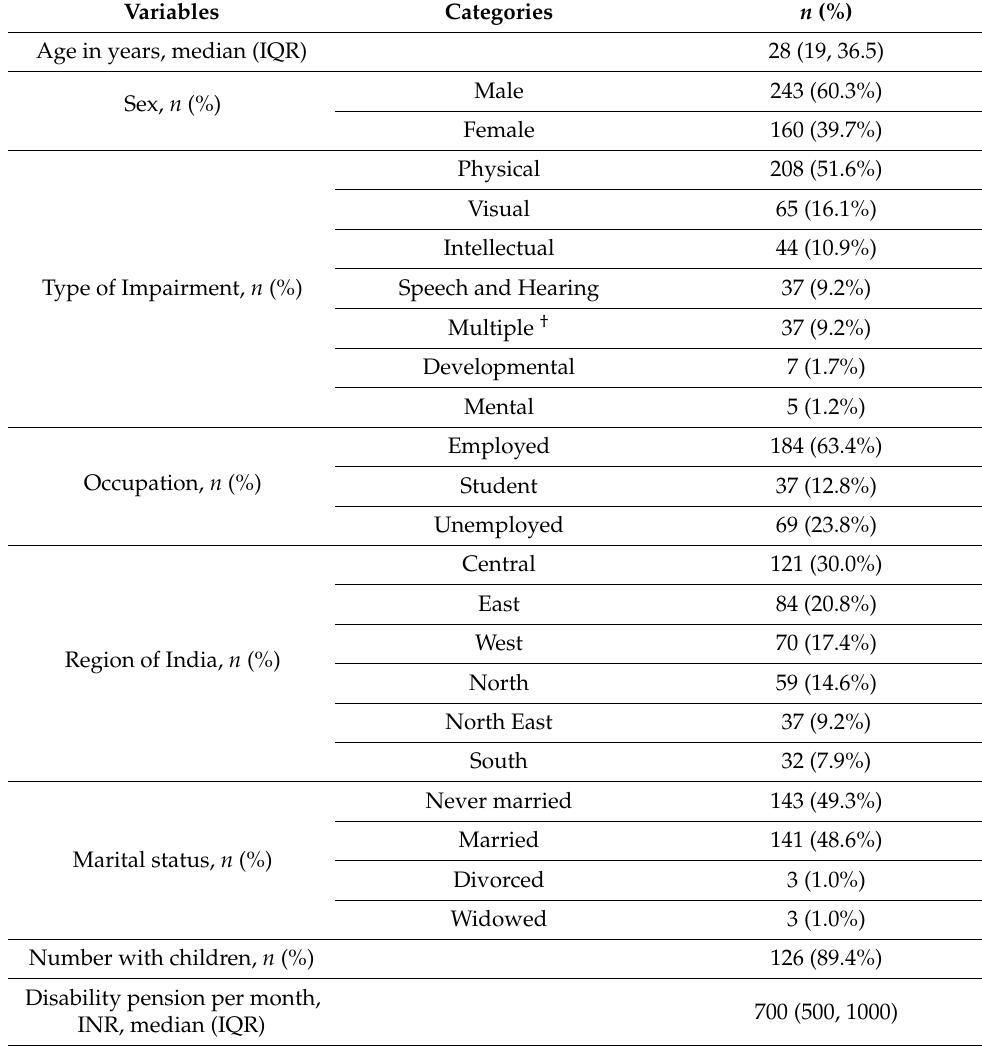
Table 1. Socio-demographic details of the study